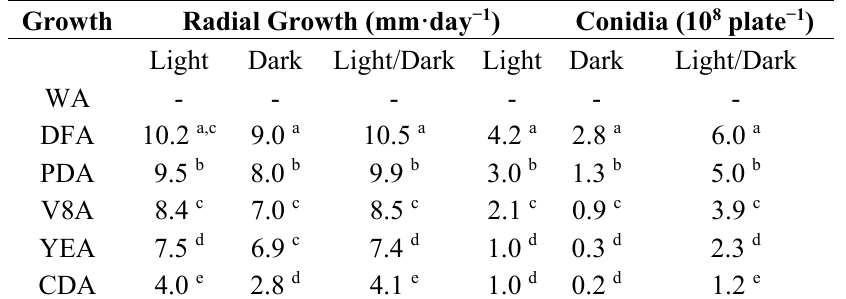
Table 1. Effect of various growth media a on radial growth and conidial production of Phoma commelinicola under various light and dark regimes b .